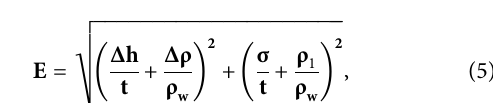
Frontiers in Earth Science |